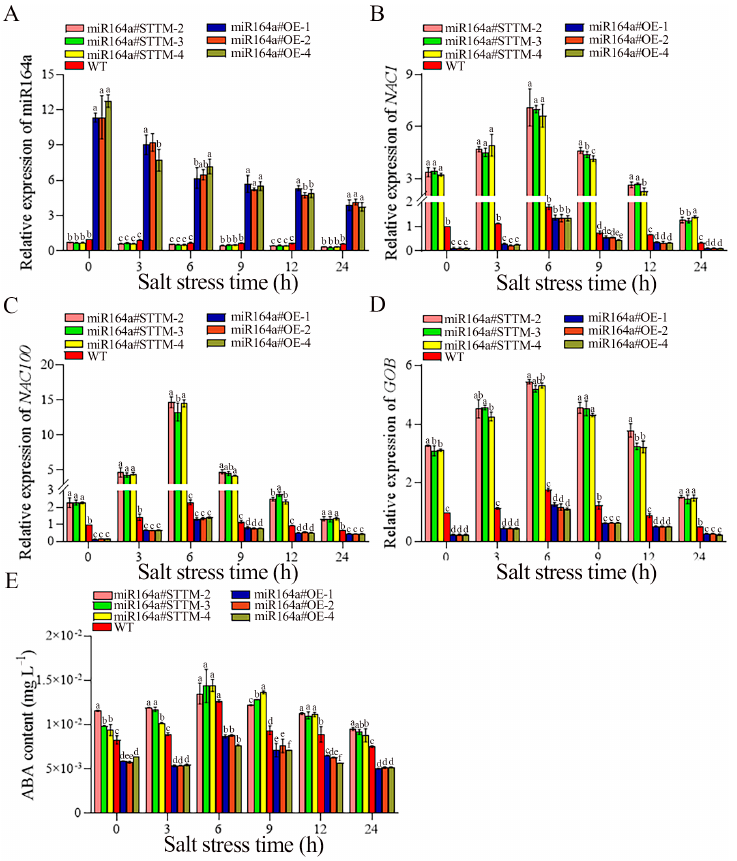
Figure 7. The expression levels of miR164a ( A ), NAC1 ( B ), NAC100 ( C ), GOB ( D ) and ABA content ( E ) in miR164a#STTM, WT and miR164a#OE tomato seedlings root during salt treatment. Vertical bars represent standard deviations of the means, n = 3. Different letters indicated significant differ- ences between WT and transgenic tomatoes in the values at p <